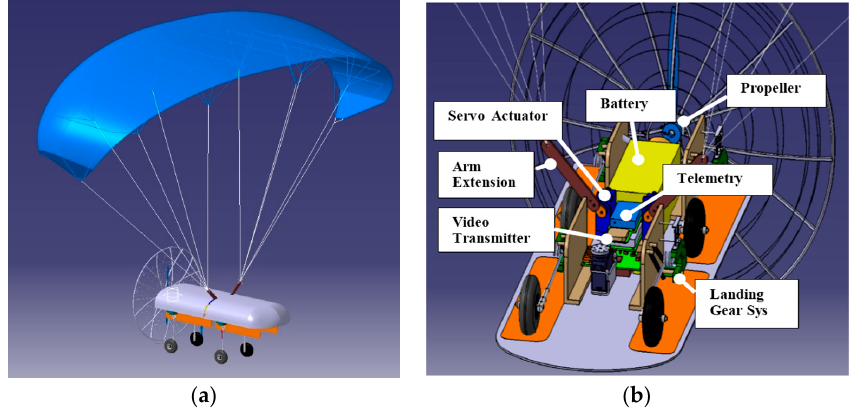
Figure 1. Unmanned Aerial Systems (UAS) main components: sail, fuselage ( a ); interior systems ( b ). Table 1. UAS main features.